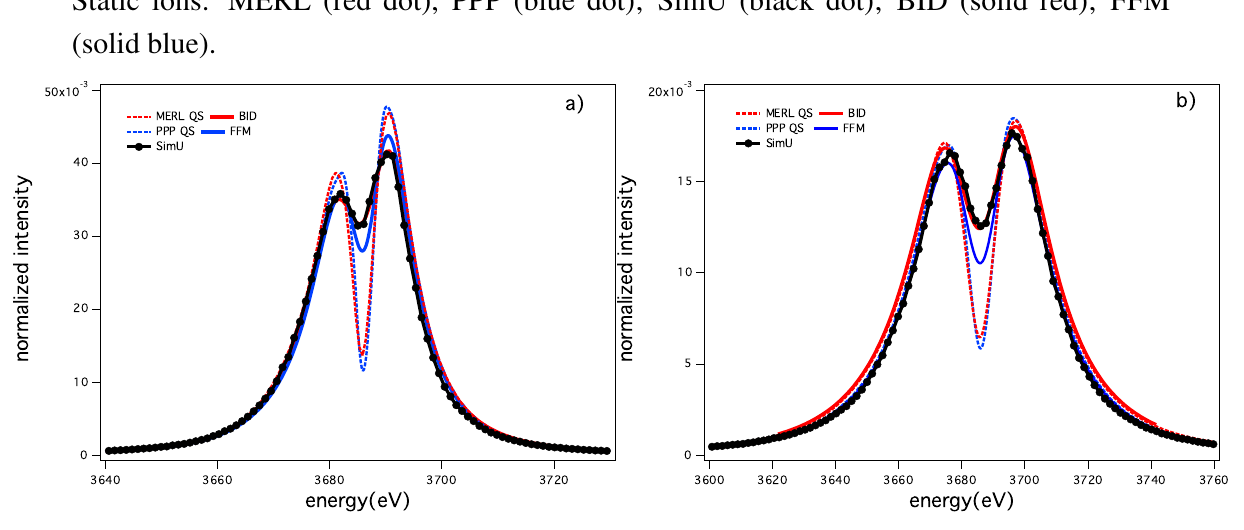
= 5 (cid:2) 10 23 cm (cid:0) 3 ; ( b ) n = 2 (cid:2) 10 24 cm (cid:0) 3 . e e